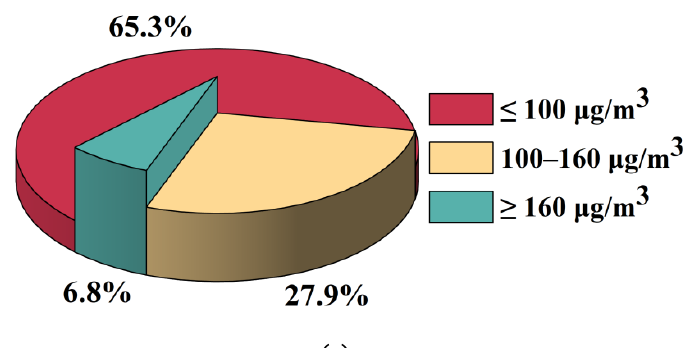
Figure 11. Percentages of grids with daily maximum 8-h average O 3 concentrations below 100 µ g/m 3 , between 100 and 160 µ g/m 3 , and above 160 µ g/m 3 based on BME in the BTH region. ( a ) in each month, ( b ) in each season, and ( c ) in 2020.